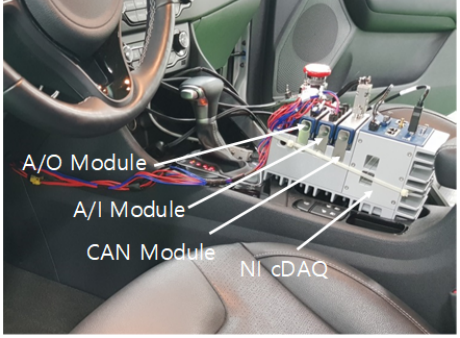
Figure 8. Hardware Vehicle